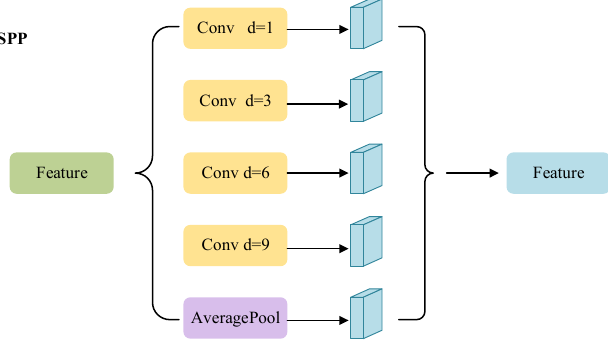
Figure 8. The ASPP block. Conv d means convolution blocks with different dilation rates.